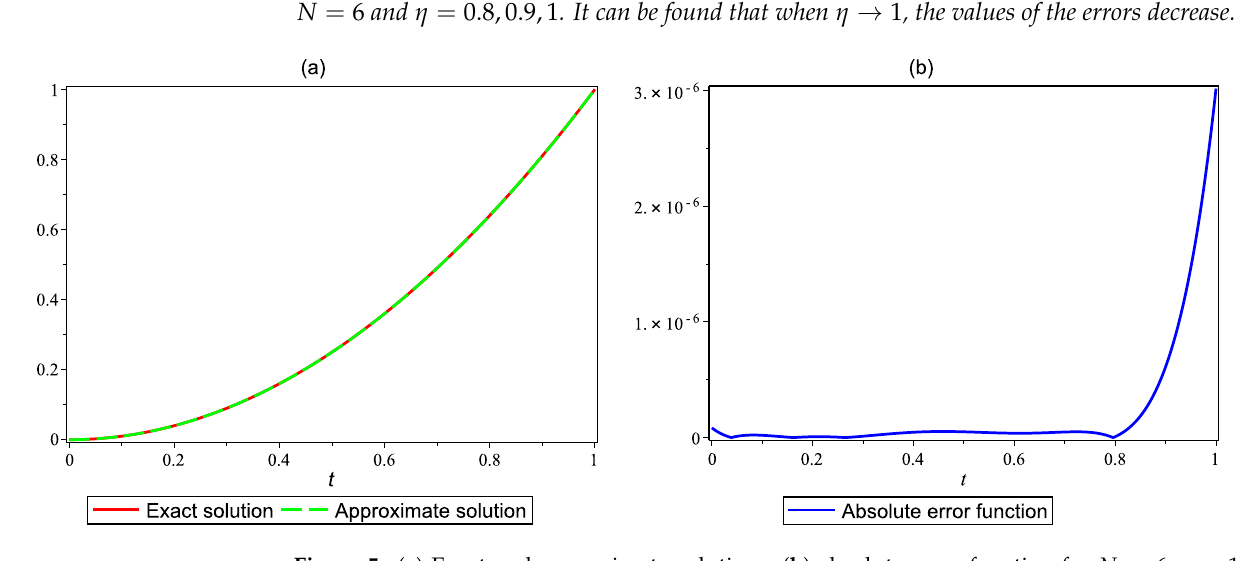
Figure 5. ( a ) Exact and approximate solutions, ( b ) absolute error function for N = 6, η = 1 for Example 3.